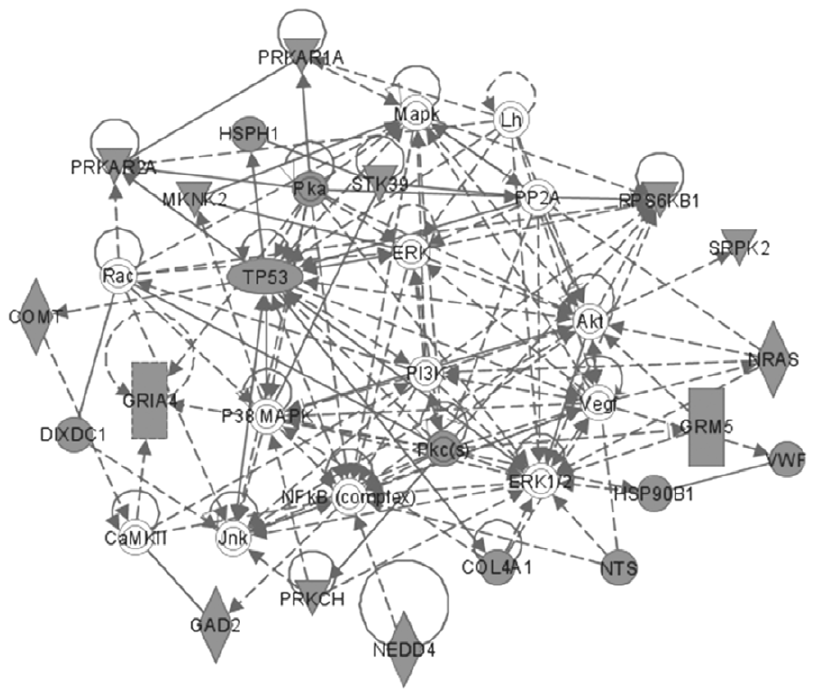
Figure 4. MAM-modulated brain gene products (anchored) for Mgmt 2 / 2 . Most significant brain expression sub-network modulated by MAM vs. vehicle in Mgmt 2 / 2 mice (all time-points combined) derived from 57 differentially expressed genes (a sub-set of the 362 genes) that were anchored to O 6 -mG levels.